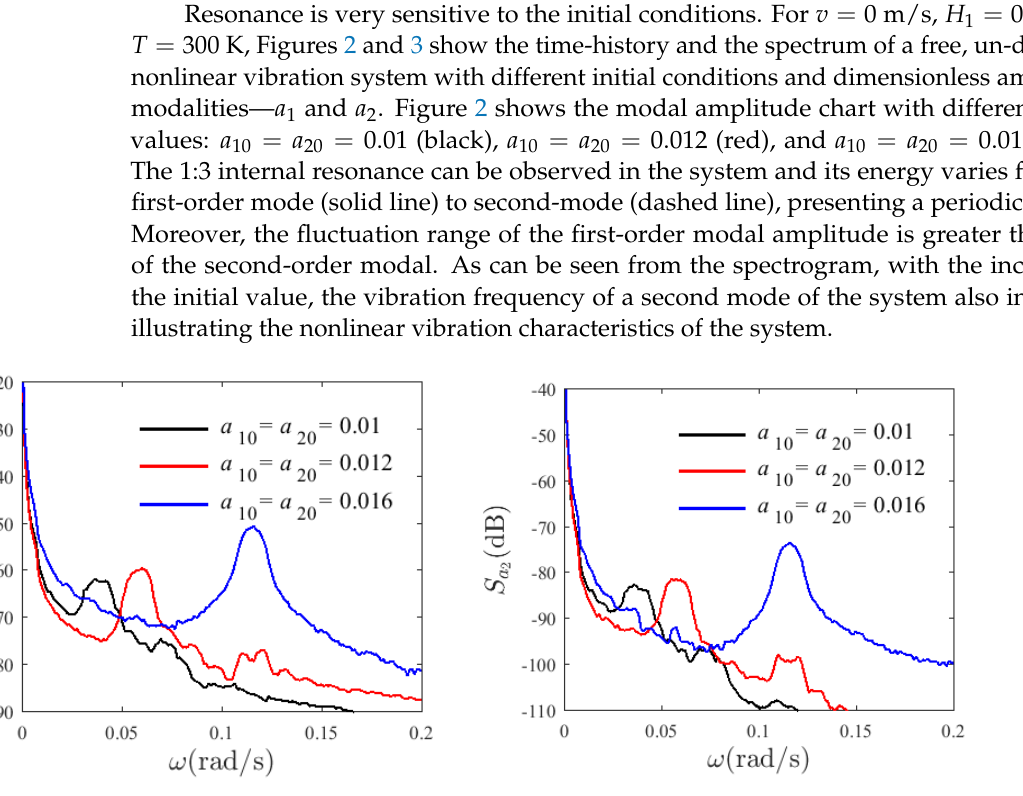
Figure 3. PSD curves of variation modes for different initial conditions a ( γ π=